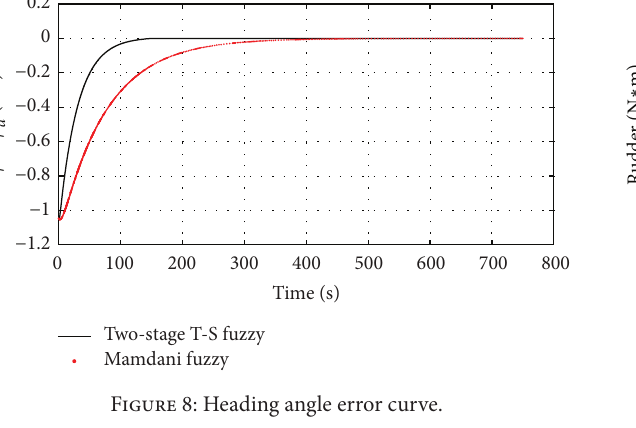
Figure 8: Heading angle error curve.